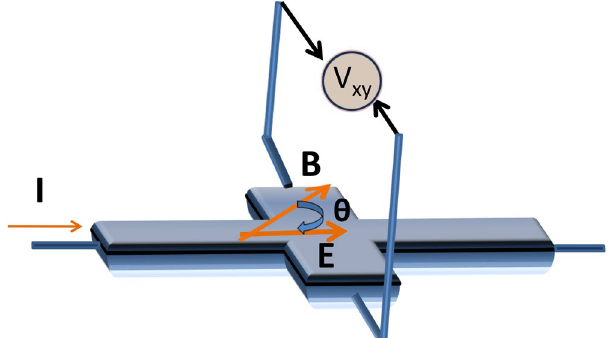
Figure 2. Illustration for the planar Hall effect measurement geometry. The electric field ( E ) is applied along the x − axis and a magnetic field ( B ) in the x − y plane makes a finite angle θ with the E . The planar Hall effect is measured as an in-plane voltage ( V xy ) transverse to the direction of current in the x − y